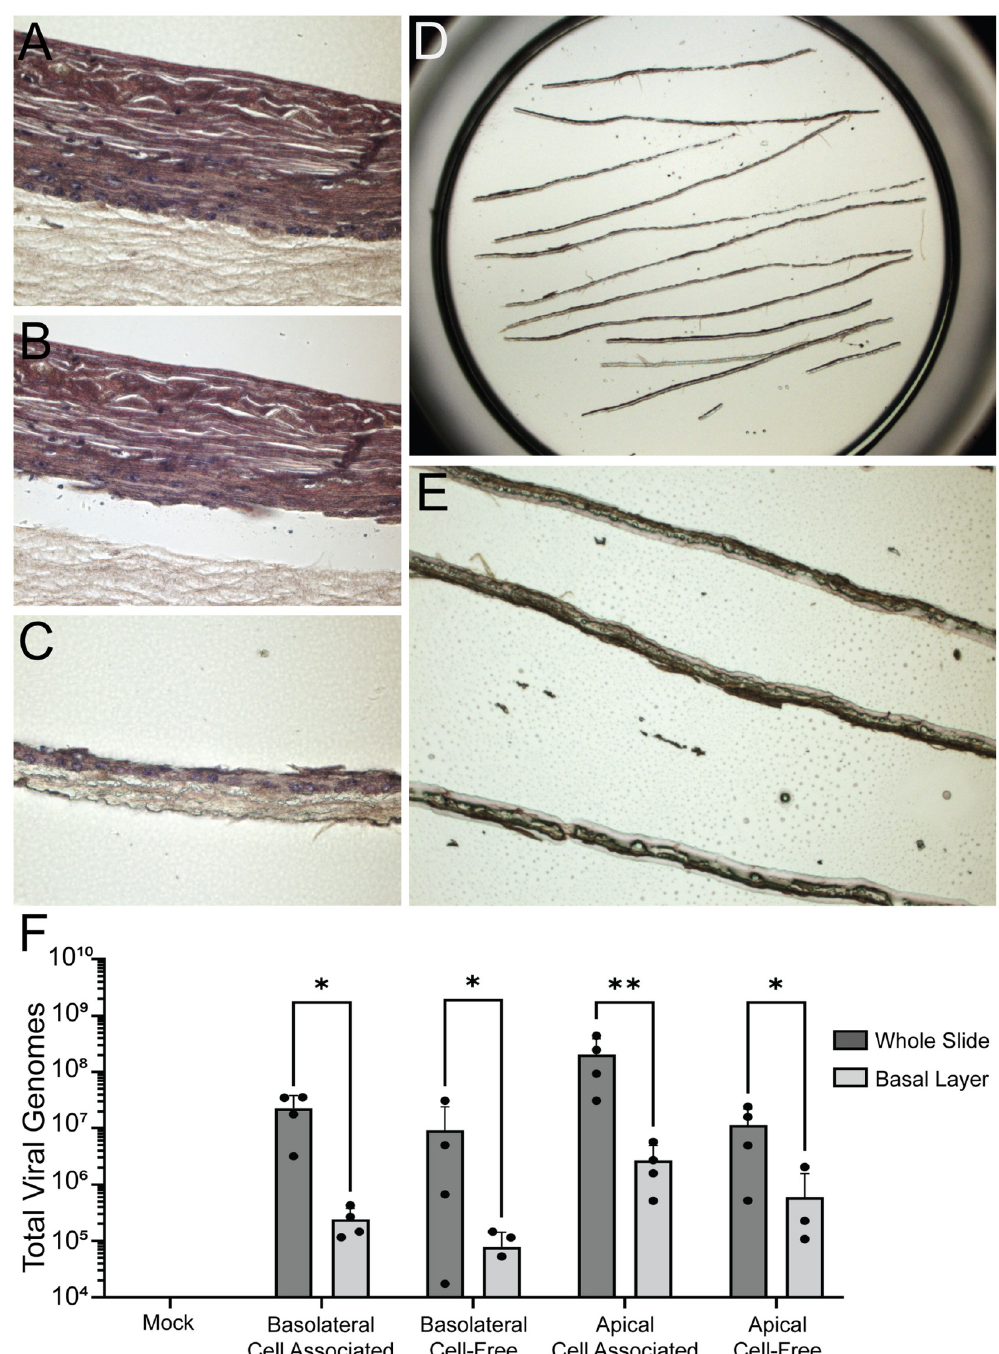
Fig 7. EBV genomes are detected in the basal layer 5 days post infection. Organotypic cultures were infected using either productively replicating B cells or cell-free virus at either the apical or basolateral surface and collected at 5 days post infection. (A) Organotypic culture section stained with hematoxylin and eosin viewed prior to capture by LCM. (B) View of the organotypic culture section from (A) after capture by LCM. (C) View of basal layer captured by LCM. (D) View of a single LCM membrane cap containing multiple pieces of captured basal layer from a single organotypic section at 2X magnification. (E) 10X magnification of captured basal layer sections in a single LCM cap. (F) qPCR quantification of viral genomes present in either an entire organotypic section from a single slide or the captured basal layer from a serial section. There was no statistically significant difference in the ‘whole slide’ or ‘basal layer’ qPCR results from cells infected with productively replicating B cells or cell-free virus (p = 0.315 and p = 0.484, respectively) following analysis by ANOVA. There